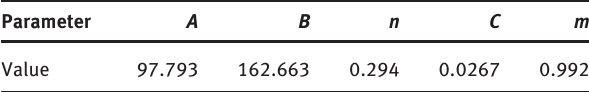
Table 2: Parameters for the Johnson – Cook model.